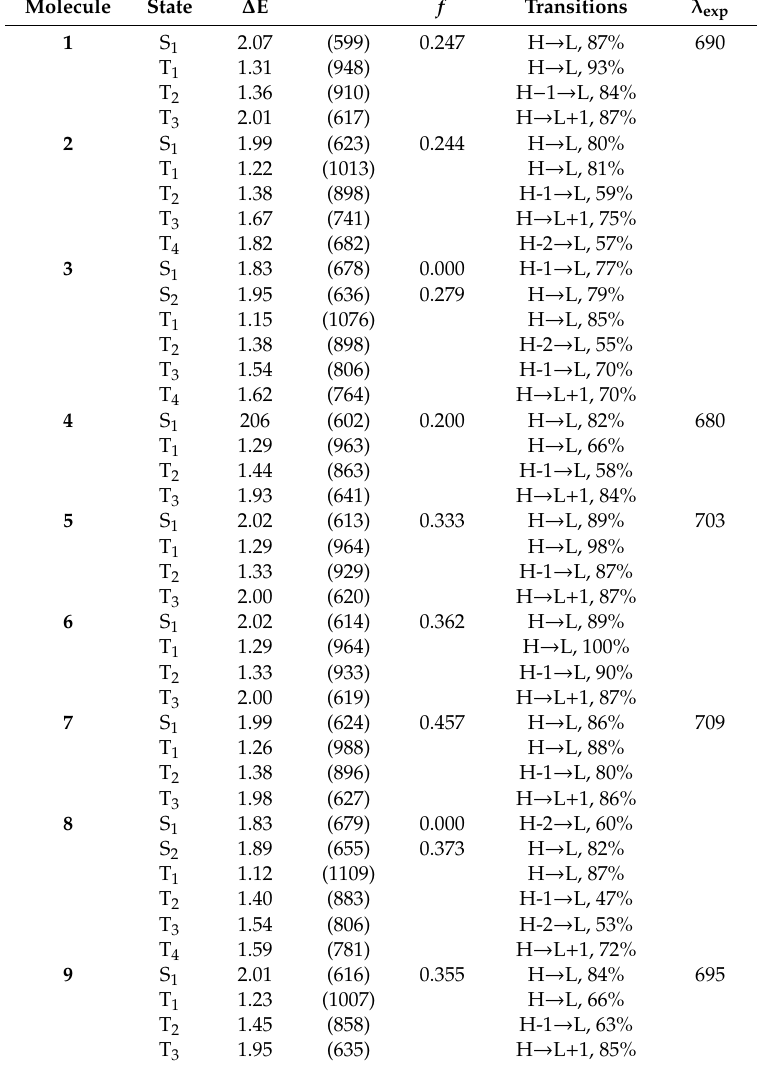
Table 1. B3LYP / 6-31 + G* vertical excitation energies, ∆ E in eV and (nm), oscillator strengths f and main orbital transitions for the studied compounds (in toluene). H = HOMO; L = LUMO. Experimental values are taken from ref.